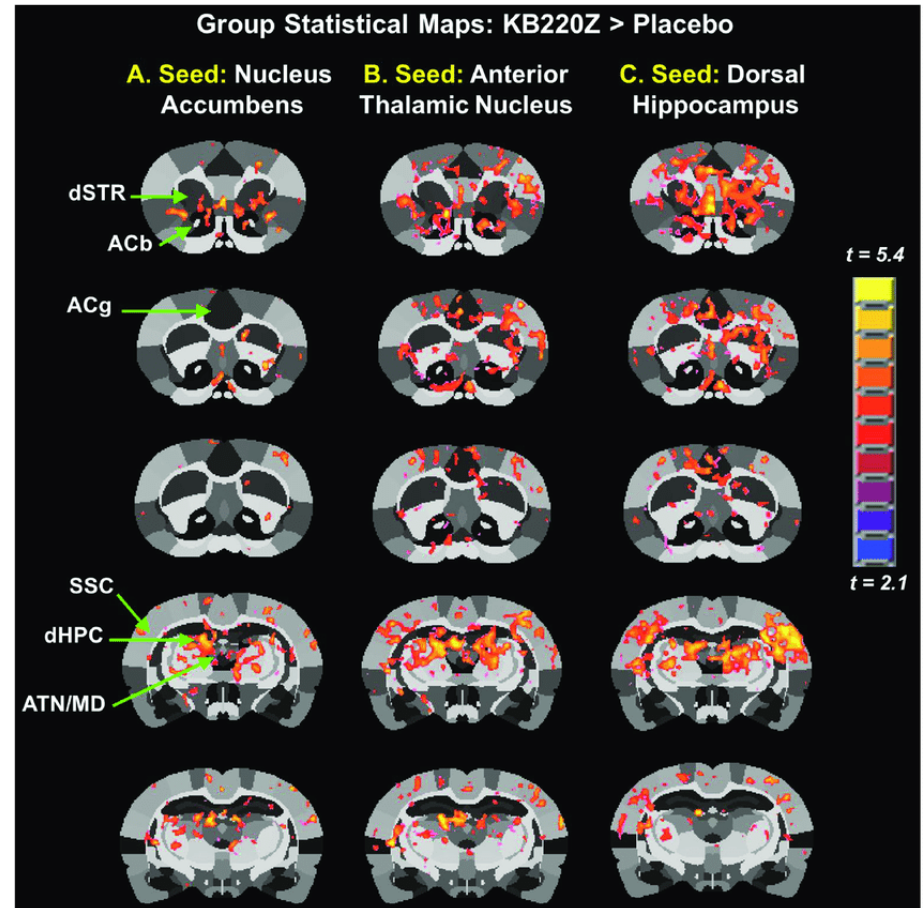
Figure 2. Group statistical maps comparing KB22OZ (Febo et al. [80], with permission).